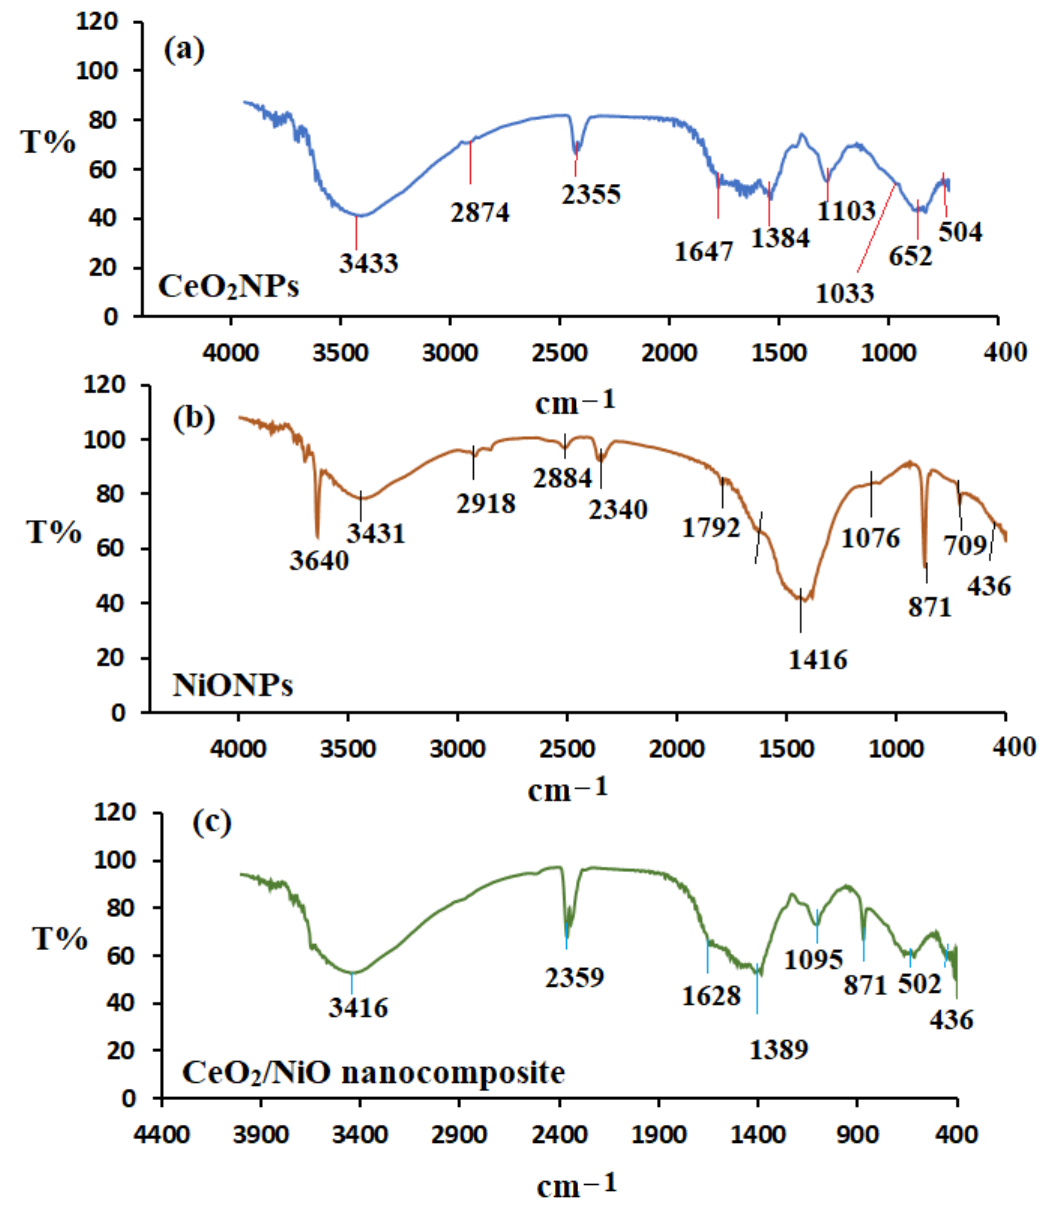
Figure 2. FT-IR analysis of ( a ) CeO 2 NPs (wheat husk extract), ( b ) NiONPs (rice husk extract) and ( c ) their CeO 2 /NiO nanocomposite, respectively, measured at 4400 – 400 nm.